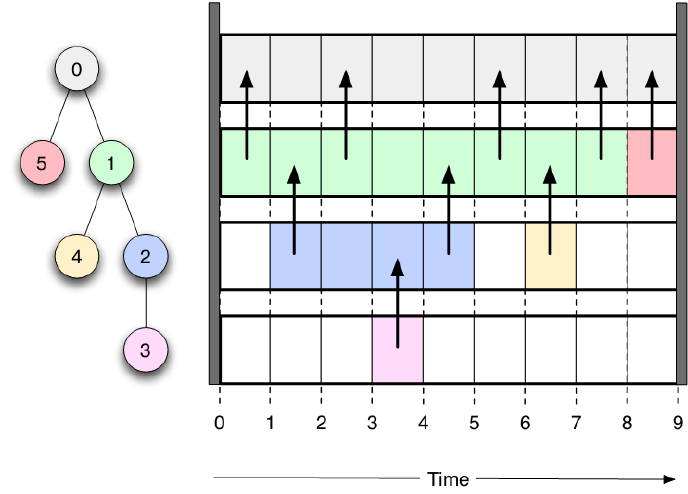
Figure 3. Example of scheduling using the conservative power scheduling (CPS)